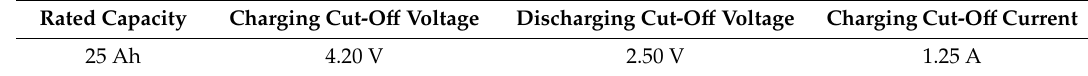
Figure 2. Configuration of the battery testing bench. Table 1. Specification of the battery.